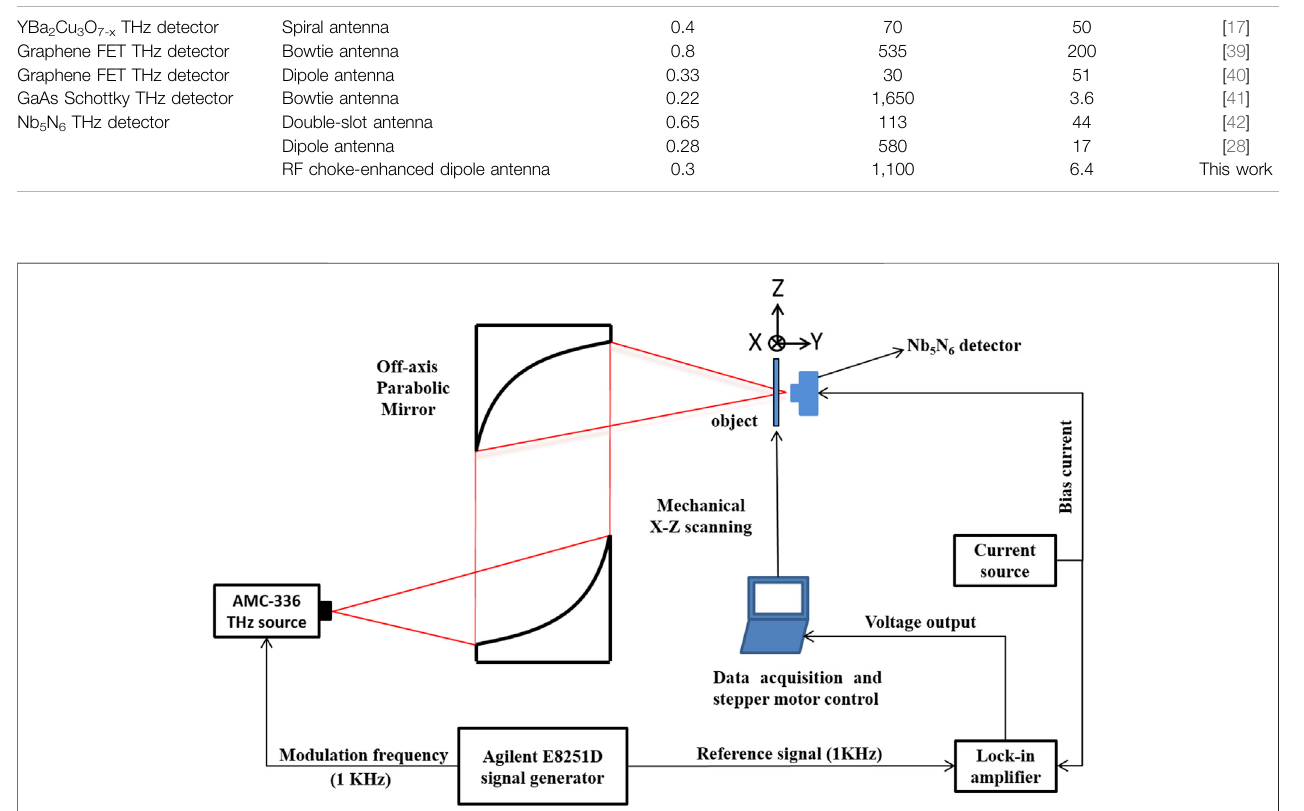
FIGURE 9 | Schematic of the developed imaging system with the Nb 5 N 6 THz detector at 0.308 THz.